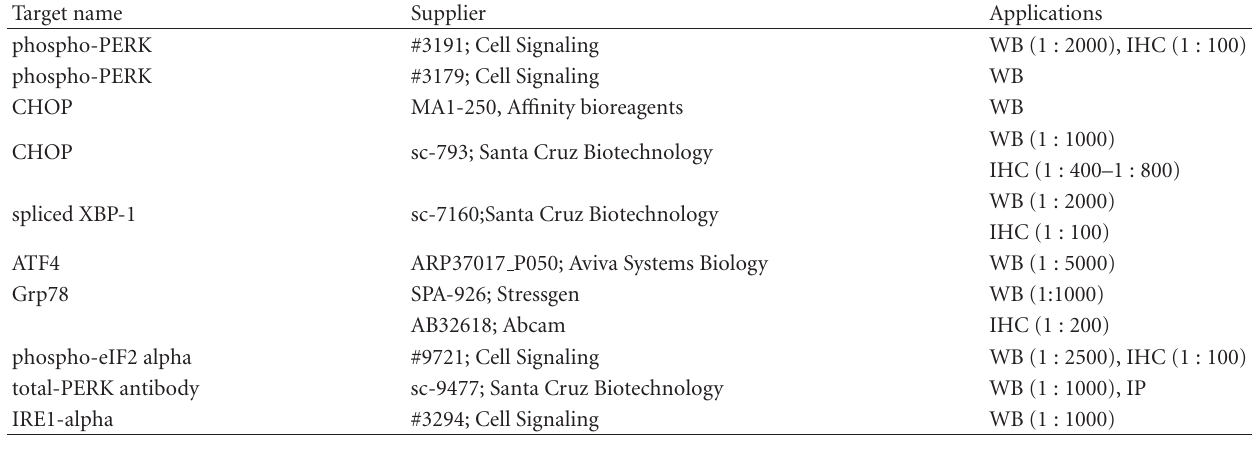
Table 2: List of antibodies that reproducibly detect markers of UPR.